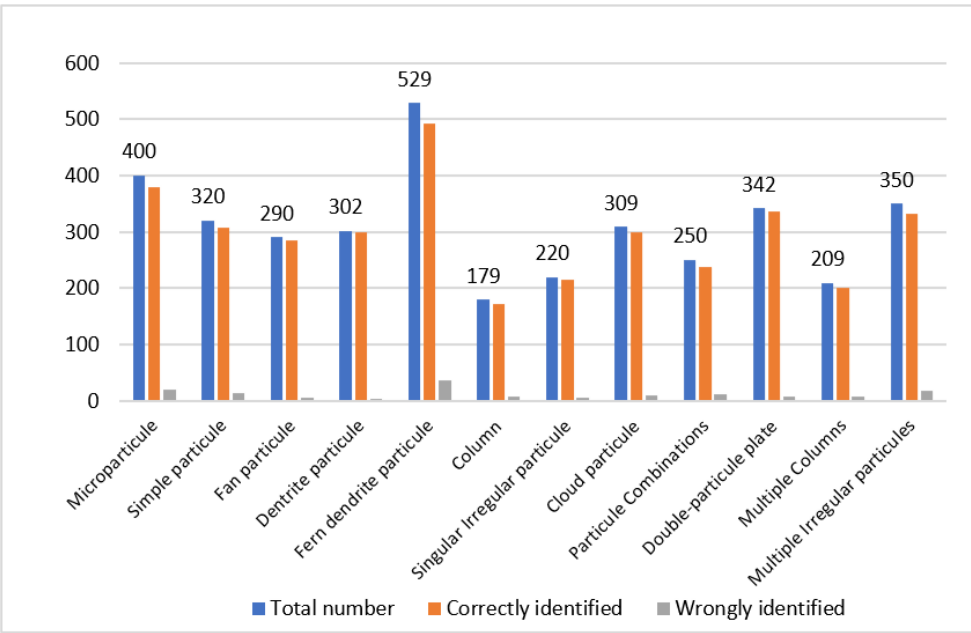
Figure 6. Number of total instances in each class for the specific output classes.